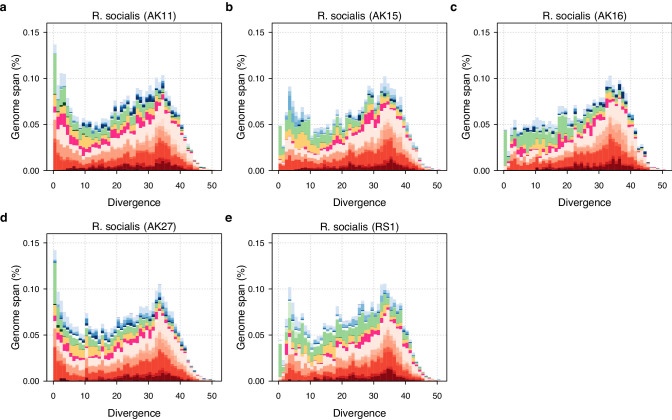
TE divergence landscapes for individual R. socialis genomes.